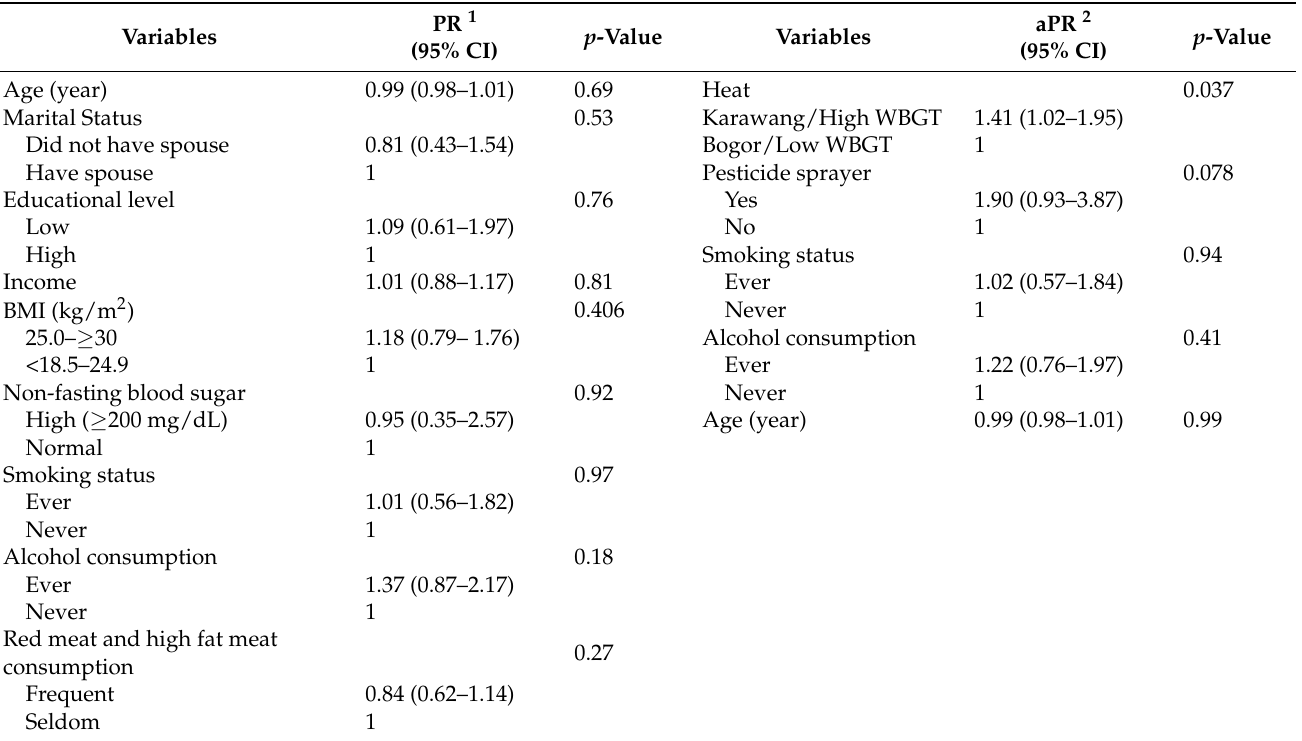
Table 4. Risk of hypertension, characteristics, lifestyle, and occupational factors among farmer in Karawang and Bogor in West Java, Indonesia